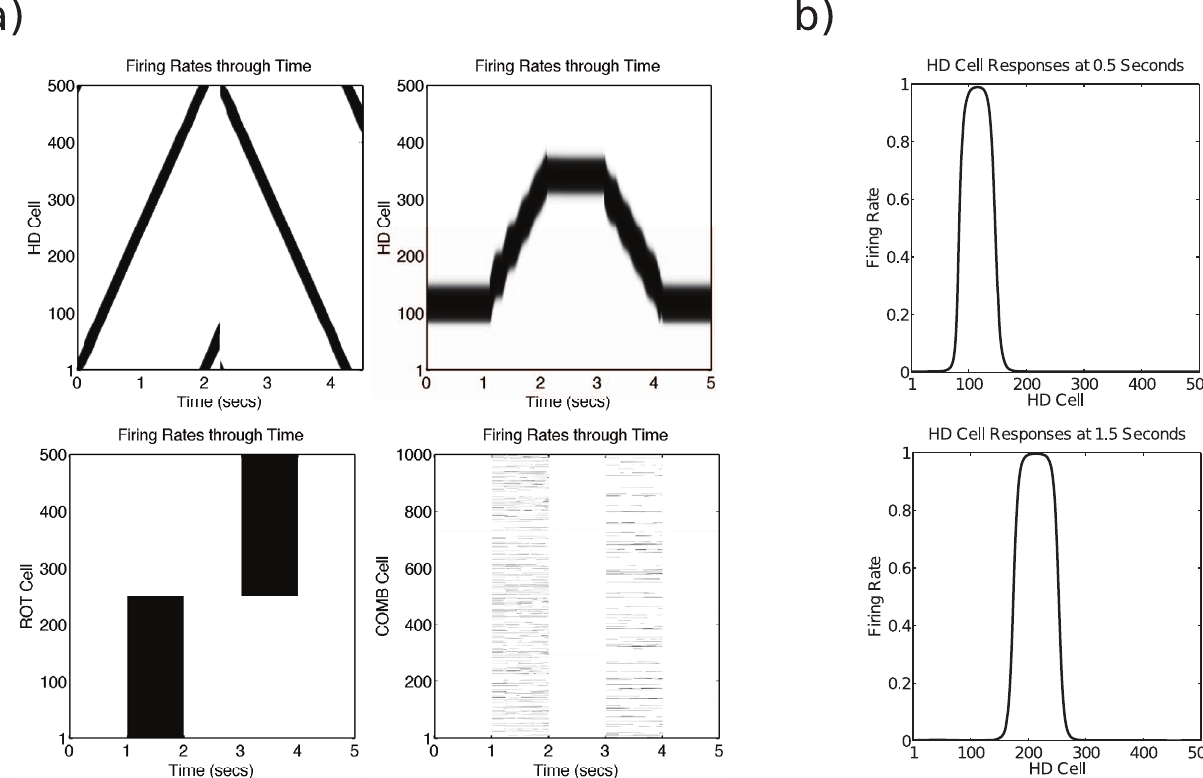
Figure 7. Firing rates of Head Direction (HD), Combination (COMB) and Rotational Velocity (ROT) cells during training and testing. These results are from a simulation with an axonal conduction delay of 100 ms, and a rotational velocity during training of 180 0 = sec (all other parameters are as given in Table 1). a) Top Left: Firing rates in the network of 500 HD cells during the 4.5 seconds of training, with the HD cells driven by visual input (0.0–2.25 seconds: agent rotating clockwise; 2.25–4.5 seconds: agent rotating counter-clockwise). Top Right: Firing rates in the network of 500 HD cells during the 5 seconds of testing in the absence of visual input. During the intervals 1.0–2.0 seconds, and 3.0–4.0 seconds, the packet of HD cell activity moves through the head-direction space of the agent driven by presynaptic COMB cell firing. During other periods, the packet of HD cell activity remains stationary and persistent due to quiescence in the presynaptic COMB cell firing. Bottom Left: Firing rates in the layer of 500 ROT cells during the 5 seconds of testing in the absence of visual input (1.0–2.0 seconds: ROT cells representing clockwise rotation are active; 3.0–4.0 seconds: ROT cells representing counter-clockwise rotation are active). Bottom Right: Firing rates in the network of 1000 COMB cells during the 5 seconds of testing in the absence of visual input. In the interval 1.0–2.0 seconds, the COMB cells become active due to the firing of the 250 ROT cells representing clockwise rotation of the agent. In the interval 3.0–4.0 seconds, the COMB cells become active due to the firing of the 250 ROT cells representing counter-clockwise rotation of the agent. In all plots, regions of high firing are represented by darker shading. It can be seen that the firing rates are rather binarized. That is, individual cells are either quiescent, or are maximally active with a firing rate of 1.0. b) The firing rates of the HD cells recorded at two different points in time. The top plot shows the firing rates of the HD cells at 0.5 seconds, while the HD cell network is maintaining a stable and persistent packet of activity in one location. The bottom plot shows the firing rates of the HD cells at 1.5 seconds, while the packet of neural activity is being shifted through the HD cell network due to the driving influence of the active ROT cells and the presynaptic COMB cells, i.e. during path integration. In both plots, the HD cell network firing profile is approximately Gaussian, reflecting the Gaussian profile of the individual HD cell response